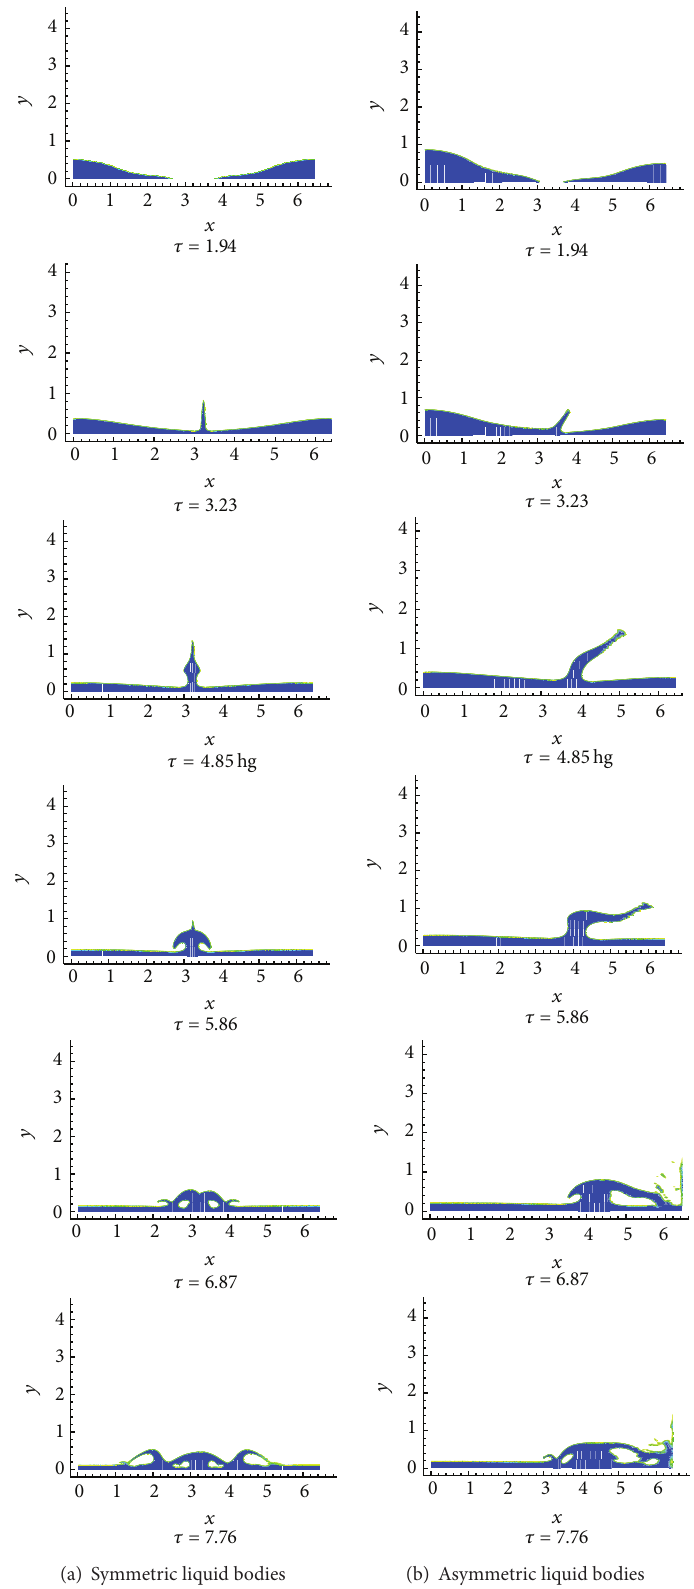
Figure 7: Free surface